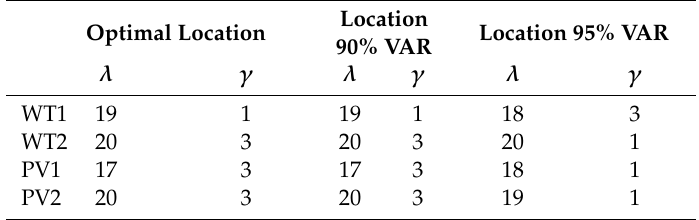
Table 3. The optimal location of WTs and PVs in the di ff erent scenarios.